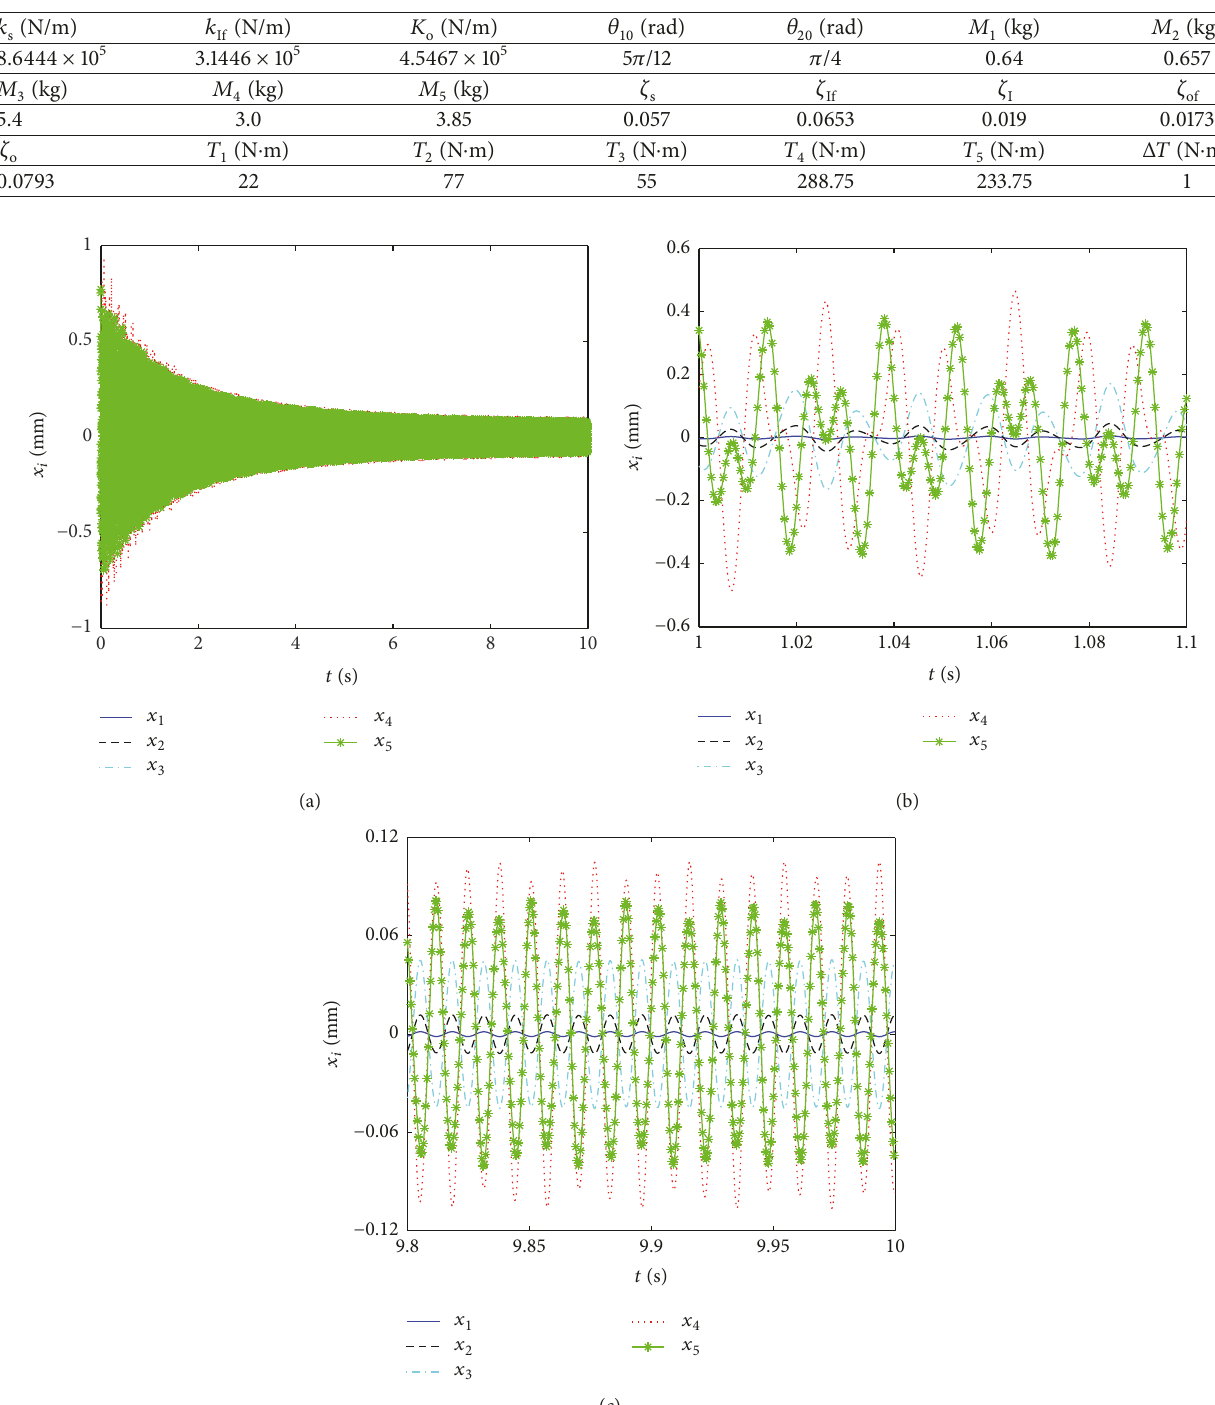
Table 2: Characteristic parameters of example EIMG system.